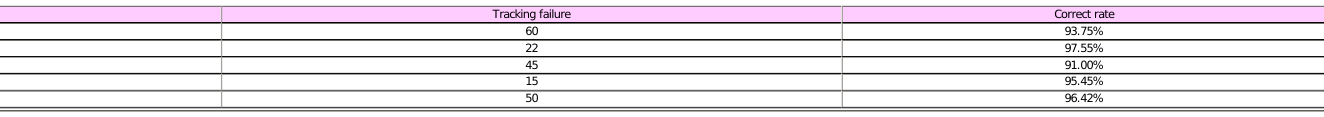
Figure 11 One time step of the Condensation algorithm (a) predicted region, (b) particles